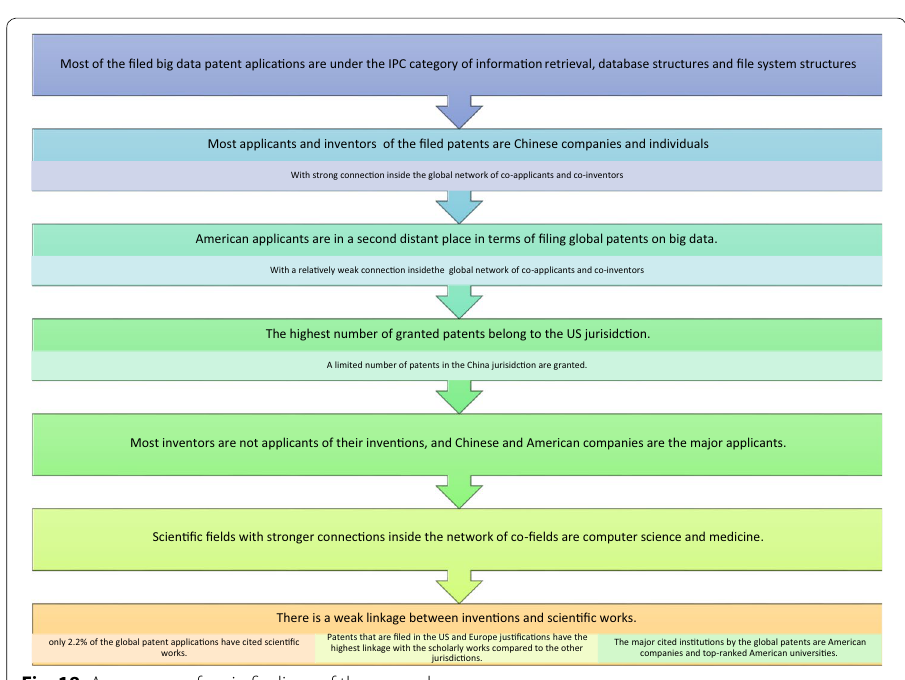
Fig. 18 A summary of main findings of the